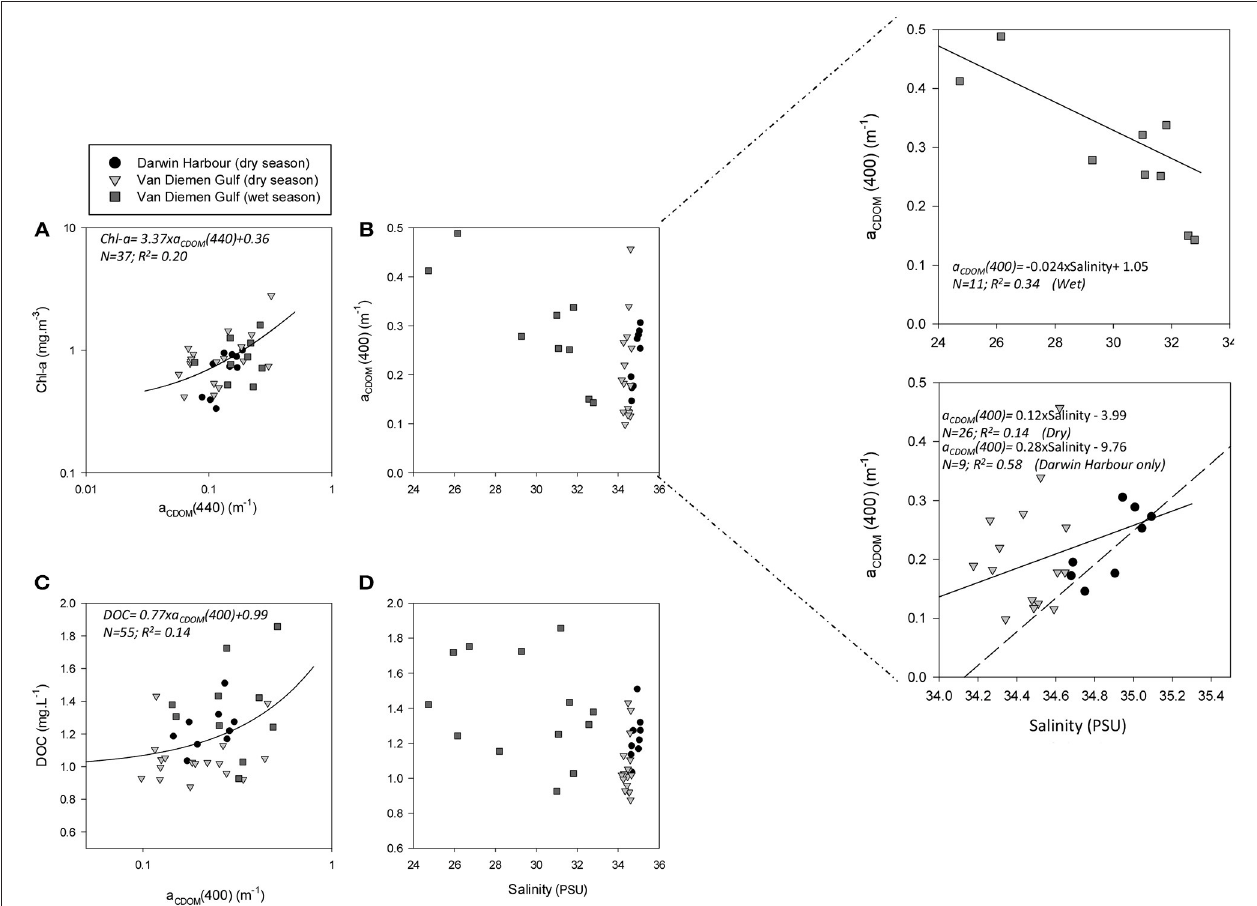
FIGURE 4 | Relationships between: (A) Chl-a and a CDOM (440), (B) a CDOM (440) and salinity, (C) DOC and a CDOM (400), and (D) DOC and salinity. The dashed line indicates the regression line for the Darwin Harbour samples only ( N = 9).